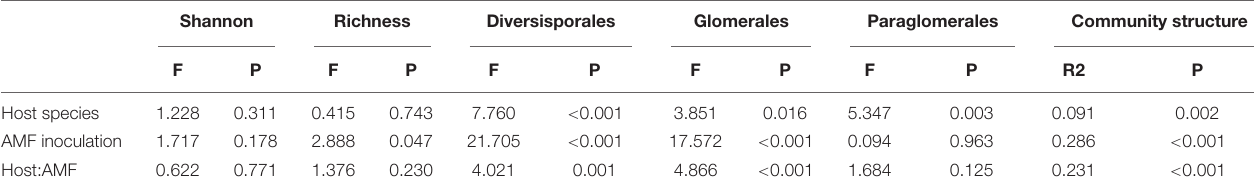
TABLE 1 | Results of two-way ANOVA and PERMANOVA showing the effects of host plant species, AMF inoculation, and their interactions on root AMF diversity, abundance (all three orders), and community structure. Shannon Richness Diversisporales Glomerales